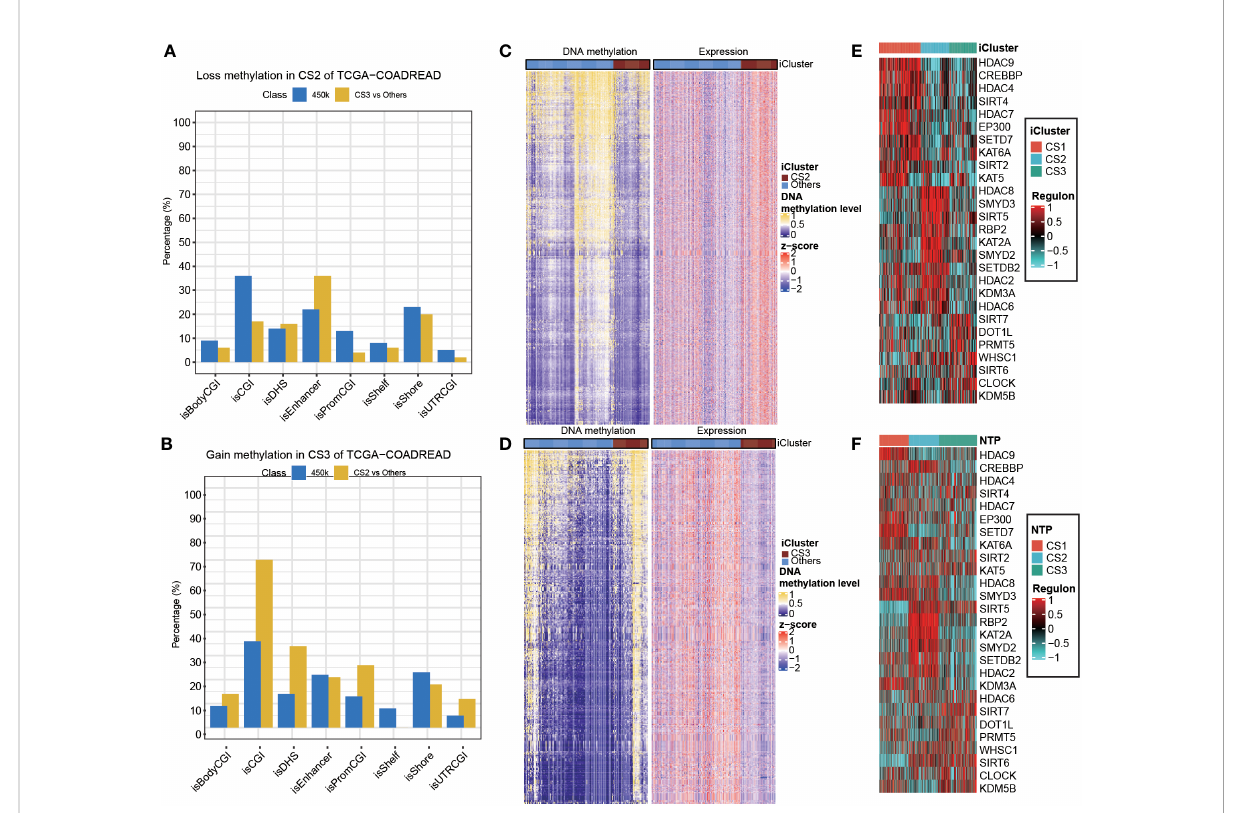
FIGURE 6 Epigenetic regulation in colorectal cancer subtype. Heatmap showing activity of regulon relevant to potential regulators associated with chromatin remodelling in both (A) TCGA and (B) GEO cohorts. Heatmap showing the association between DNA methylation and gene expression, presenting with (C) an epigenetic activation pattern in CS2 and (D) an epigenetically silencing pattern in CS3 of TCGA cohort. Barplots showing the region-speci fi c distribution of DMPs comparing to the Illumina 450karray background for the (E) CS2 and (F) CS3 molecular classi fi cation in TCGA